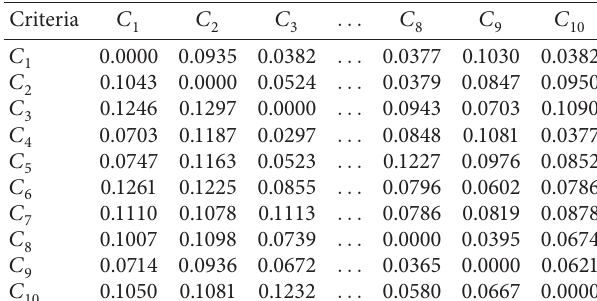
Table 7: Aggregated DRM with real numbers. Criteria